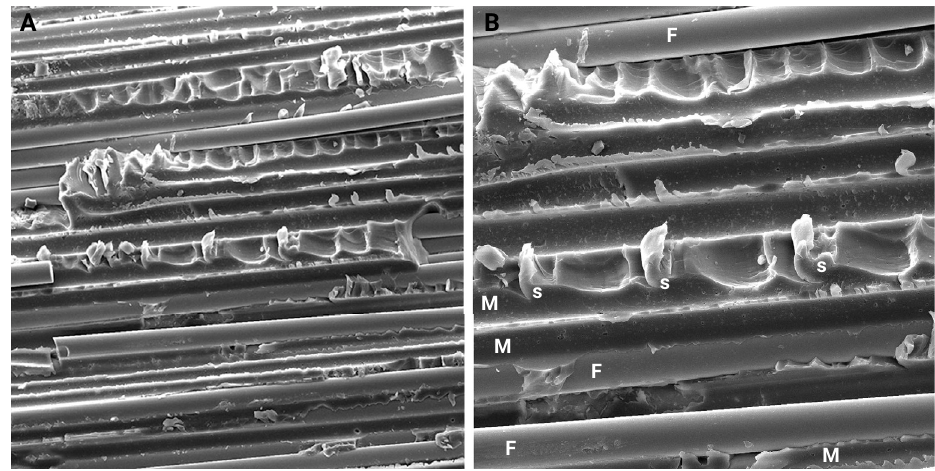
Figure 2. SEM images of the shear failures in the GFPs. A. Representative SEM of the WP group x500. B. SEM (x1000) of the WP group presenting the F: glass fiber, M: epoxy matrix and S: scallops (undulations on the epoxy matrix consequences of the shear